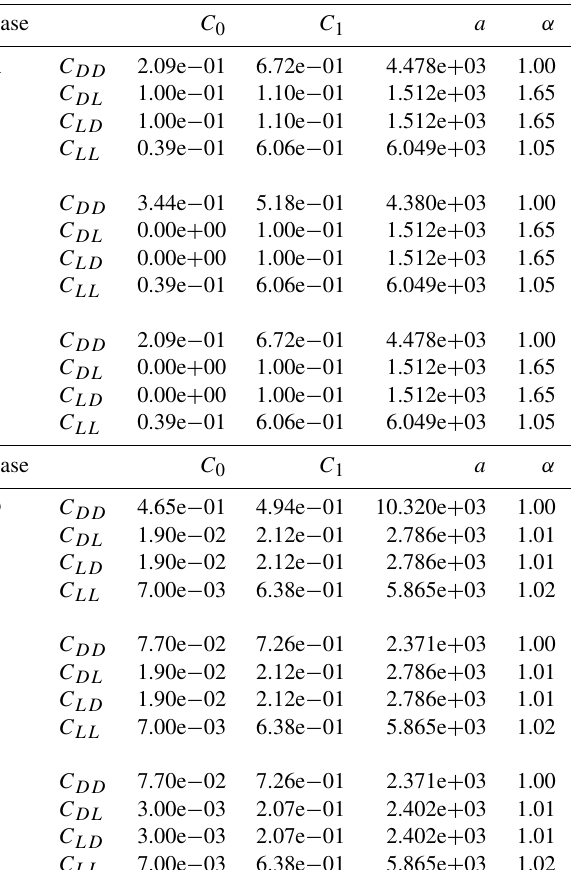
Table 3. Covariance and cross-covariance model parameters ∗ Eq. (16) used for